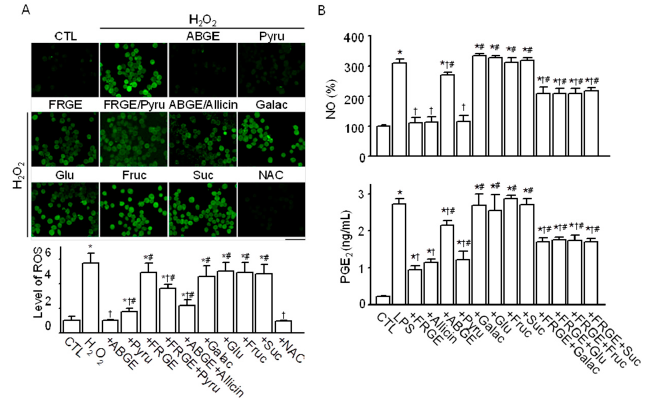
Figure 3. High anti-oxidant and low anti-inflammatory effects of ABGE compared with FRGE. anti-oxidant effect of ABGE. Pyruvate, not sugar, is responsible for the anti-oxidant effect of ABGE. RAW264.7 cells were incubated with H 2 DCFDA to evaluate ROS generation. The ROS levels were quantified using fluorescence microscopy after 3 h of treatment with 100 µ M pyruvate, 1 µ M allicin, 100 µ M sugars, 1000 µ g/mL garlic extracts, or 1 mM NAC in the H 2 O 2 (100 µ M)-treated cells. The scale bar represents 50 µ m. * p < 0.05 compared with the control (CTL). † p < 0.05 compared with the H 2 O 2 treatment. # p < 0.05 compared with the ABGE treatment; ( B ) Reduction of the anti-inflammatory effect of FRGE by pretreatment with sugars. Production of NO and PGE 2 was measured in media collected from LPS-stimulated RAW264.7 cells. * p < 0.05 compared with the control (CTL). † p < 0.05 compared with the LPS treatment. # p < 0.05 compared with the FRGE treatment. Each bar represents the mean ˘ SD of three independent experiments. The plus (+) sign represents conditions with